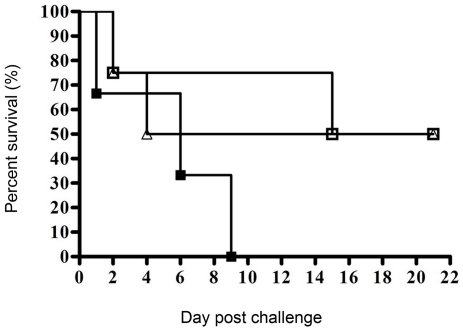
Survival of BALB/c mice immunised with recombinant Omp3 or Omp7 and challenged with B. pseudomallei.Mice were immunised with either Omp3 (open triangles) or Omp7 (open squares) prior to challenge with 1×106 cfu B. pseudomallei by the i.p. route of infection. Both groups immunised with either Omp3 or Omp7 displayed 50% survival rate up to 21 days post-infection. All the control mice (closed squares) received E. coli BL21 (DE3) cells in FIA followed by challenge, and died by day 9 post-challenge.